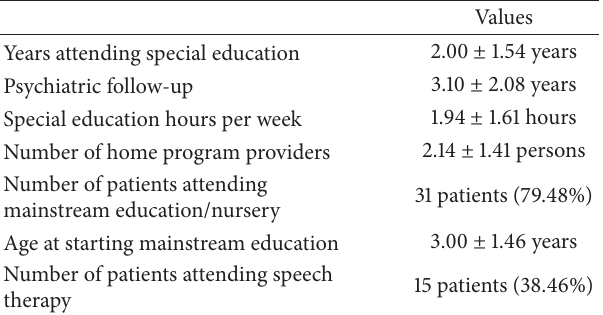
Table 1: Education program of the